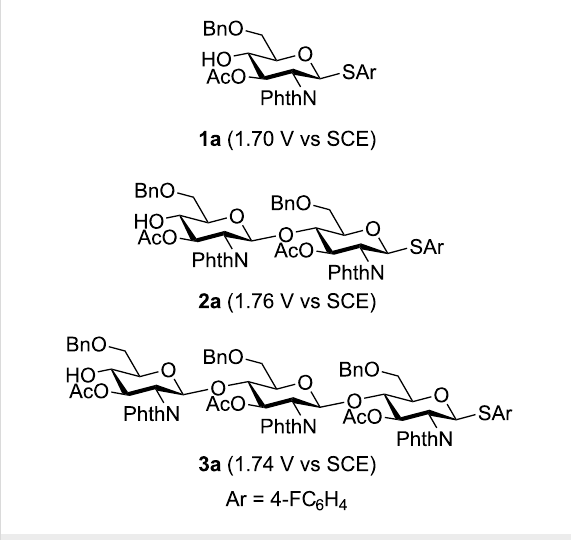
Figure 8: Oxidative potential of monosaccharide 1a , disaccharide 2a , and trisaccharide 3a .